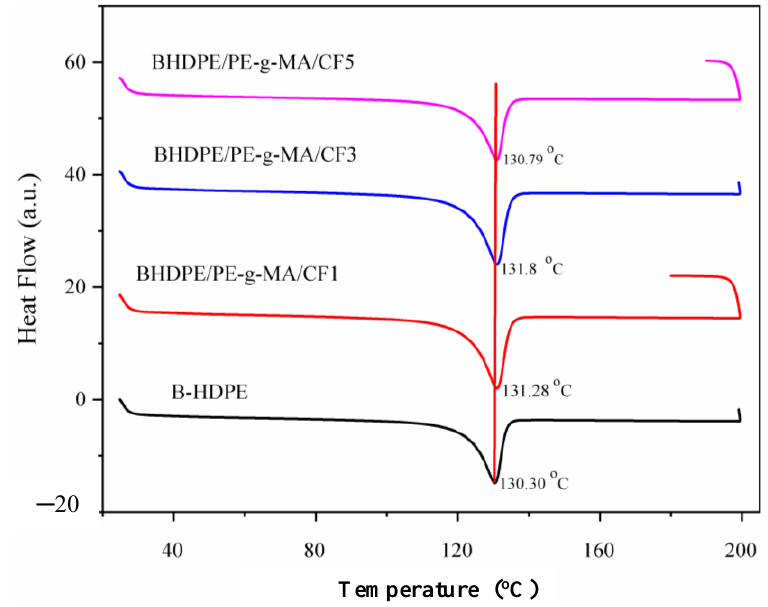
Figure 4. Melting thermograms of B-HDPE and biocomposites.